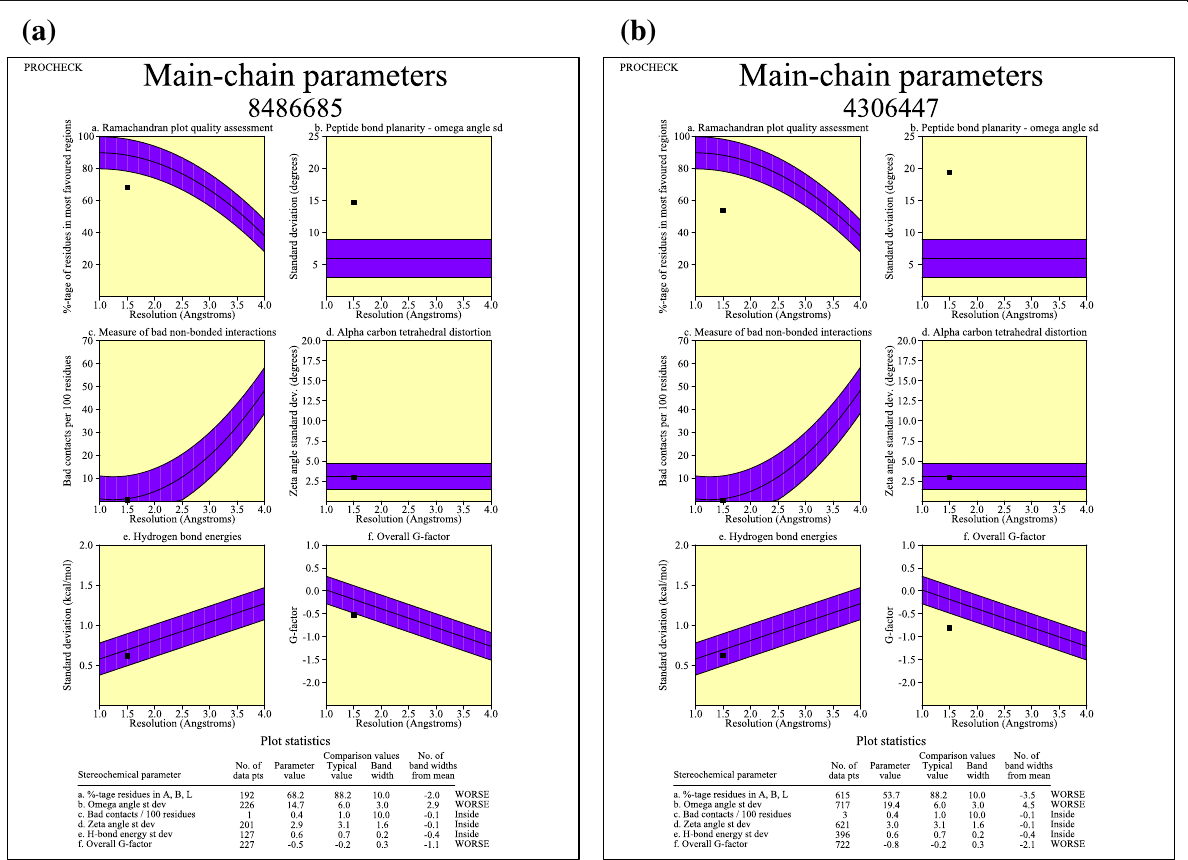
Fig. 10 The plot cocoonase ( a ) and sericin ( b ) showing graphs of five main-chain properties of the structure and how these properties compared with well-refined structures at a similar resolution. In each graph, the dark band represents the results from the well-refined structures; the central line is a least-squares fit to the mean trend as a function of resolution, while the width of the band either side of it corresponds to a variation of one standard deviation about the